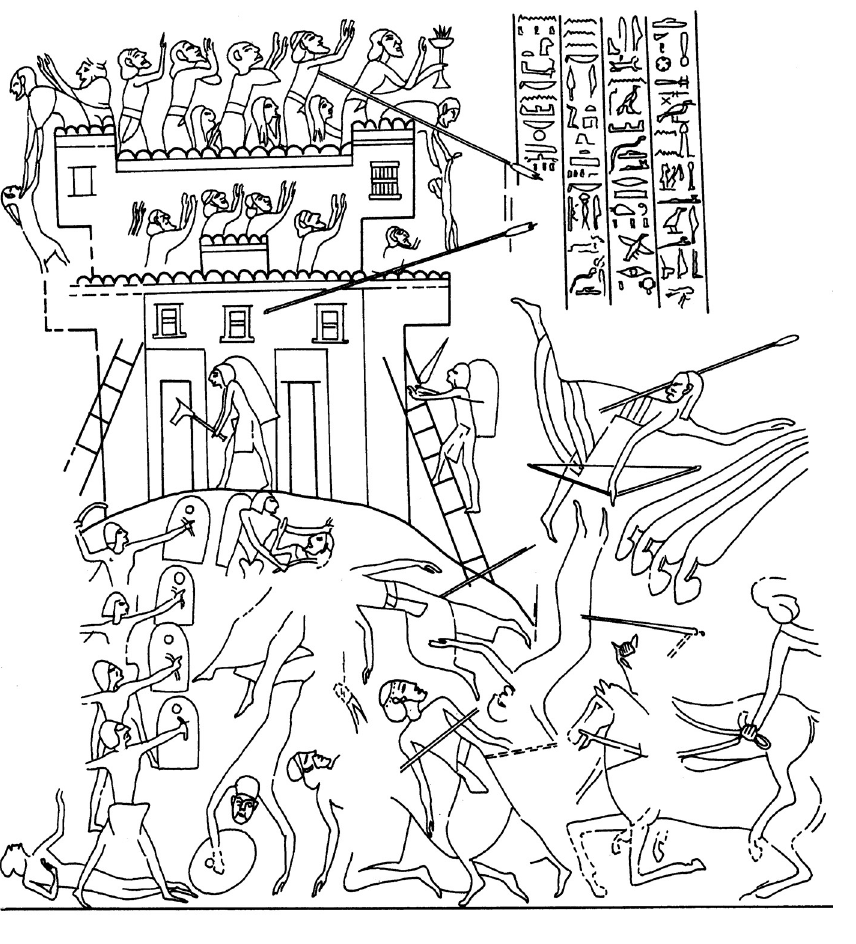
Figure 5 Egyptian relief from Karnak depicting the Egyptian army besieging the Canaanite city of Ashkelon (Fig. 1), dating to the reign of Merenptah (1213–1203 BC ) – a graphic representation of military con- frontation between two cultures (modified from figure 3 in L. E. Stager (1985; see n. 9